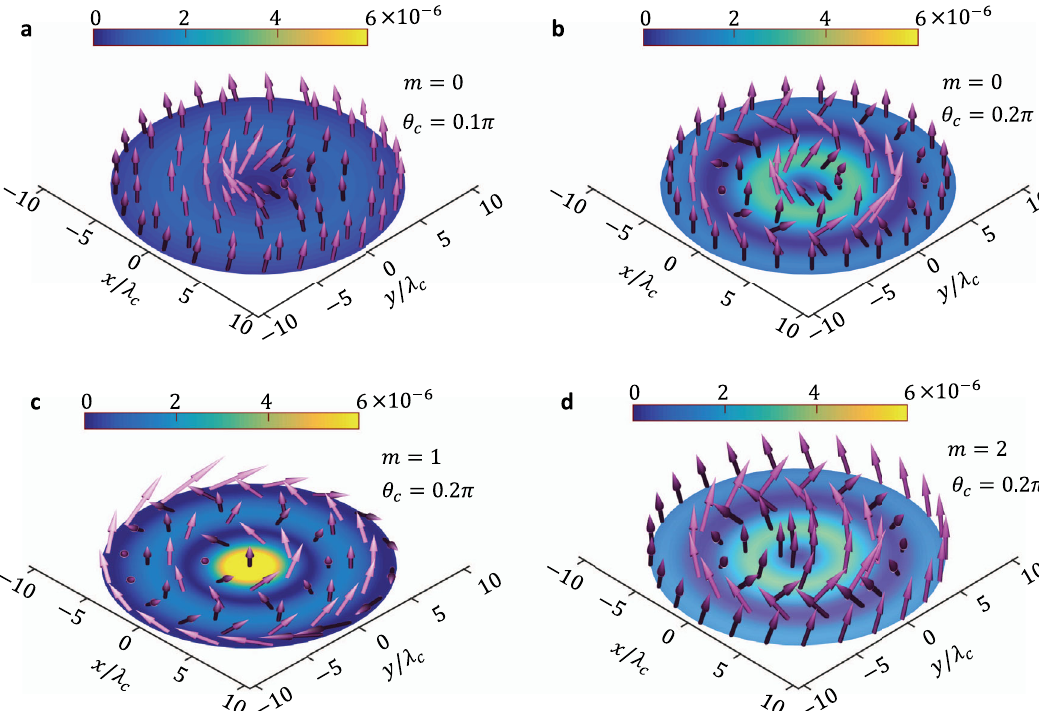
Fig. 4 Helical spin texture of twisted quantum pulse. Spin texture of a single-photon left-circular-polarized Bessel pulse on the pulse-center plane with k z z = ct . a − d Correspond to different quantum numbers m and polar angles θ c . The colorbar describes the amplitude of spin density in unit of _ = λ 3 , c